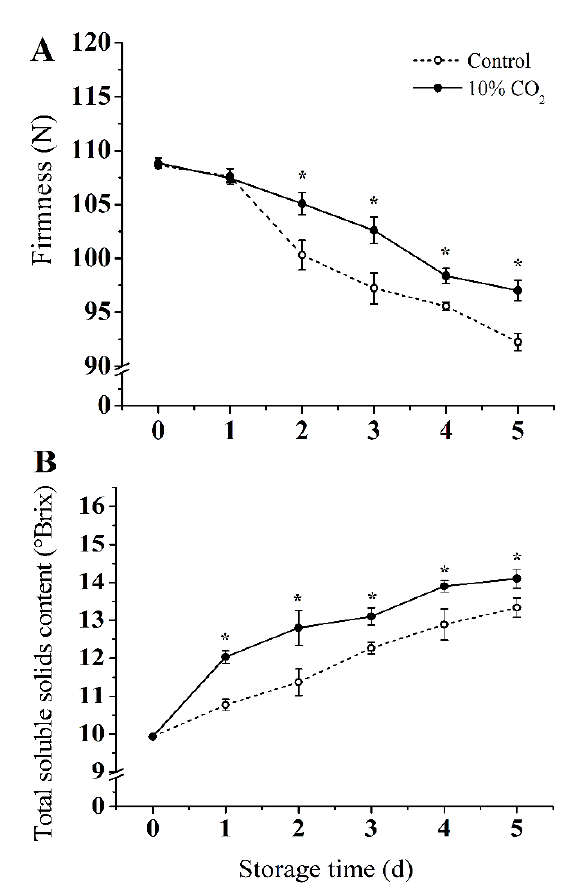
Figure 1. Effect of CO 2 on firmness ( A ), and total soluble solids ( B ) of fresh-cut pear fruit during storage. Values are presented as means ± SD ( n = 9). Asterisks (*) indicate significant differences at the same time between controls and CO 2 -treated fruit according to the Student’s-test ( p < 0.05).